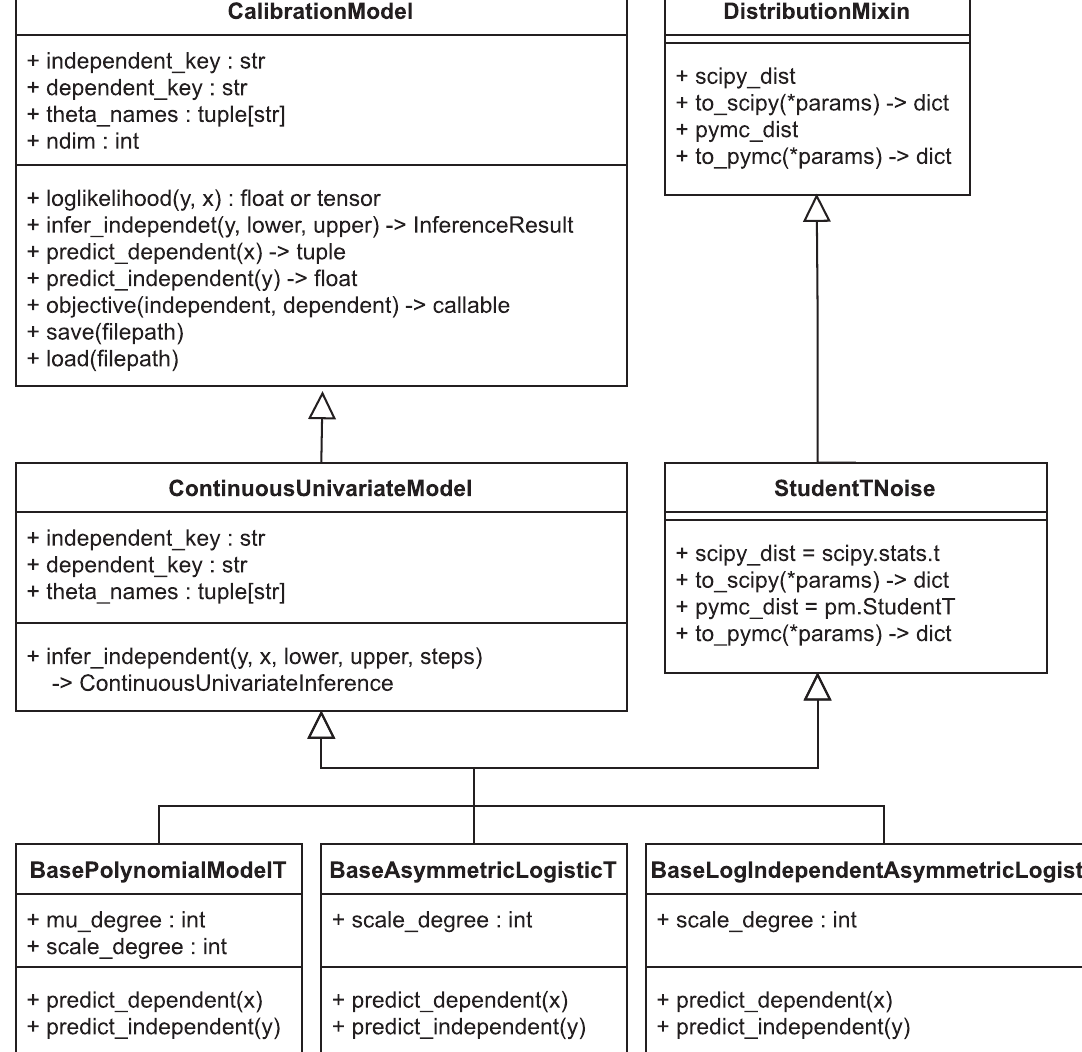
Fig 6. calibr8 class diagram. All calibr8 models inherit from the same CalibrationModel and DistributionMixin classes that define attributes, properties and method signatures that are common to all calibration models. Some methods, like loglikelihood() or objective() are implemented by CalibrationModel directly, whereas others are implemented by the inheriting classes. Specifically the predict_ � methods depend on the choice of the domain expert. With a suite of Base � T classes, calibr8 provides base classes for models based on Student- t distributed observations. A domain expert may start from any of these levels to implement a custom calibration model for a specific application.